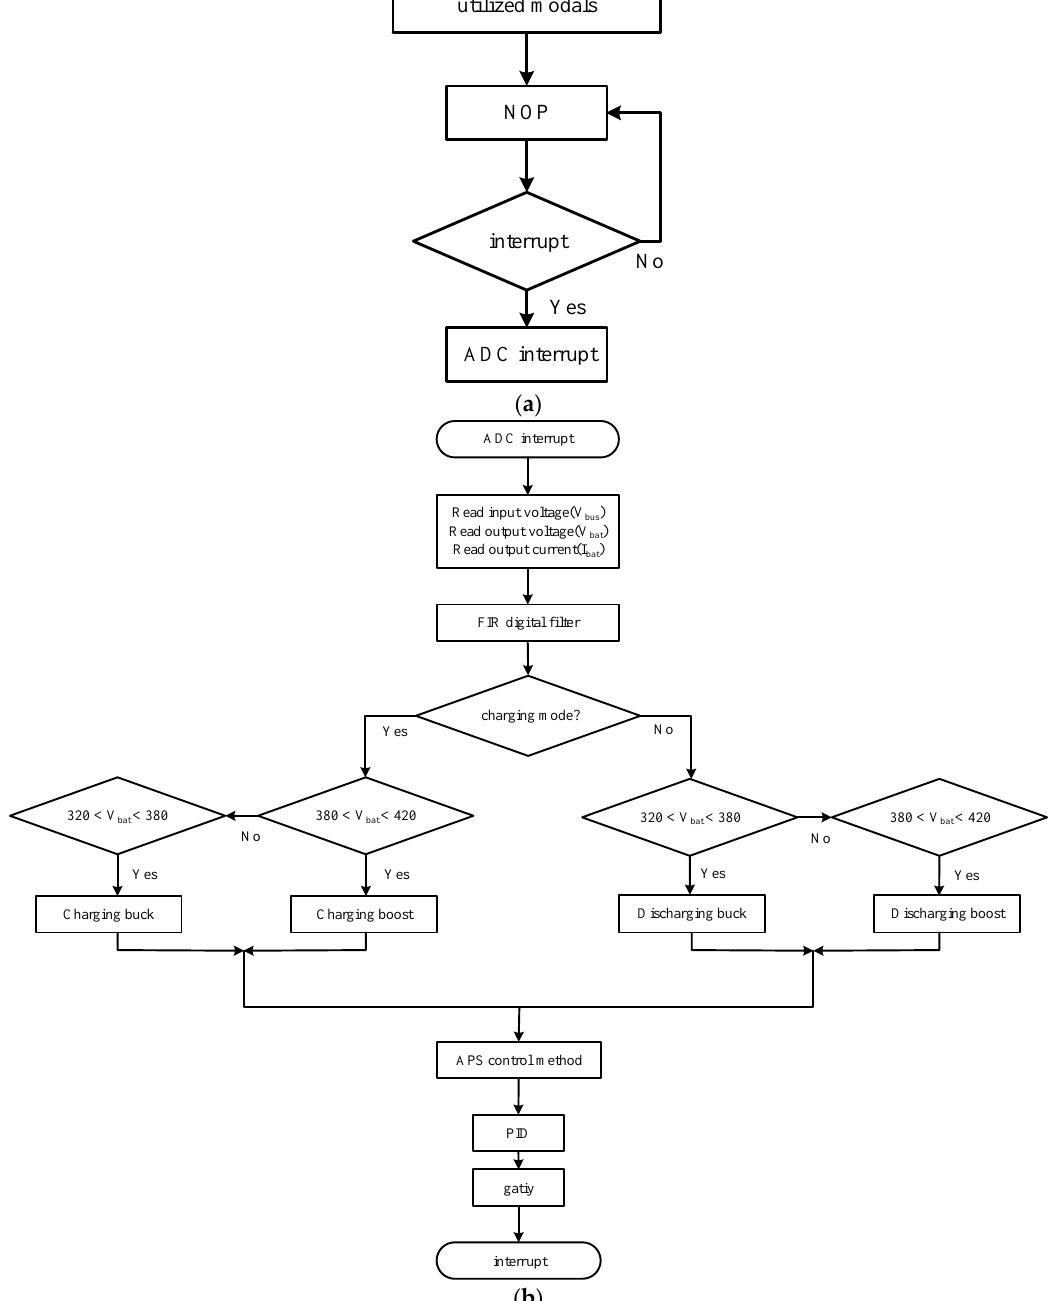
Figure 10. Flowchart of the control algorithm: ( a ) Main program; ( b ) ADC interrupt subroutine.